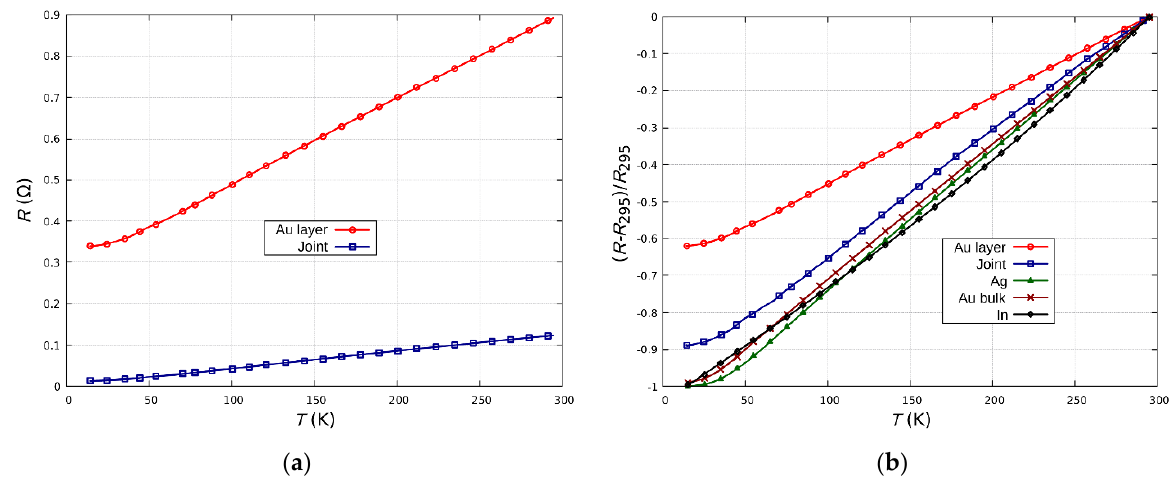
Figure 10. Temperature dependence of resistances ( a ) and relative changes in resistances ( b ) for an Au/In/Ag (sample A) joint and Au layer on a ceramic substrate.